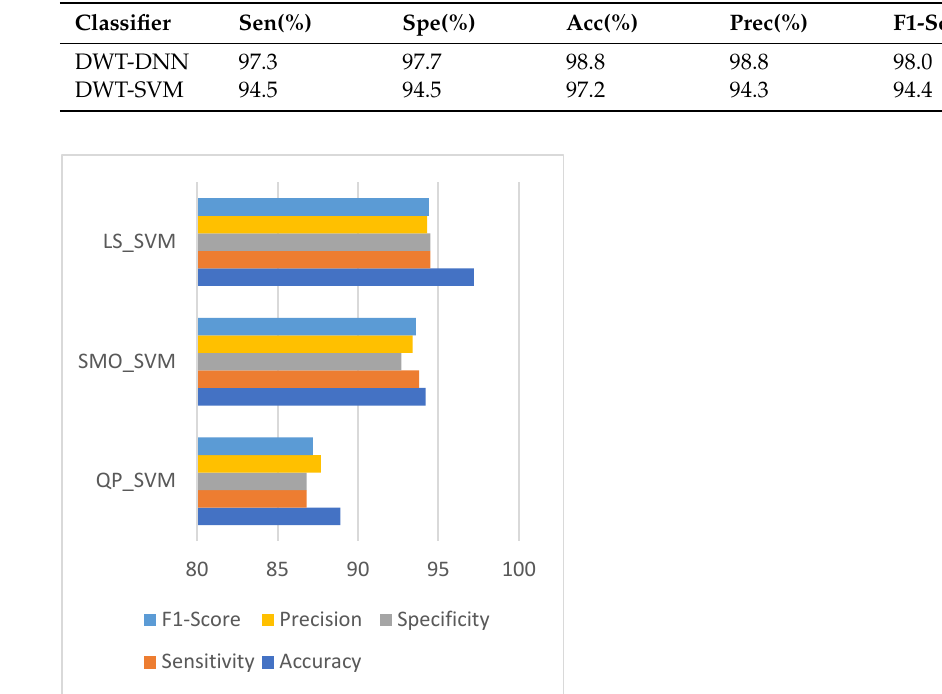
Figure 10. Performance of Different SVM types for Time-Frequency features. Table 3. Different kernel function of SVM with DWT features.